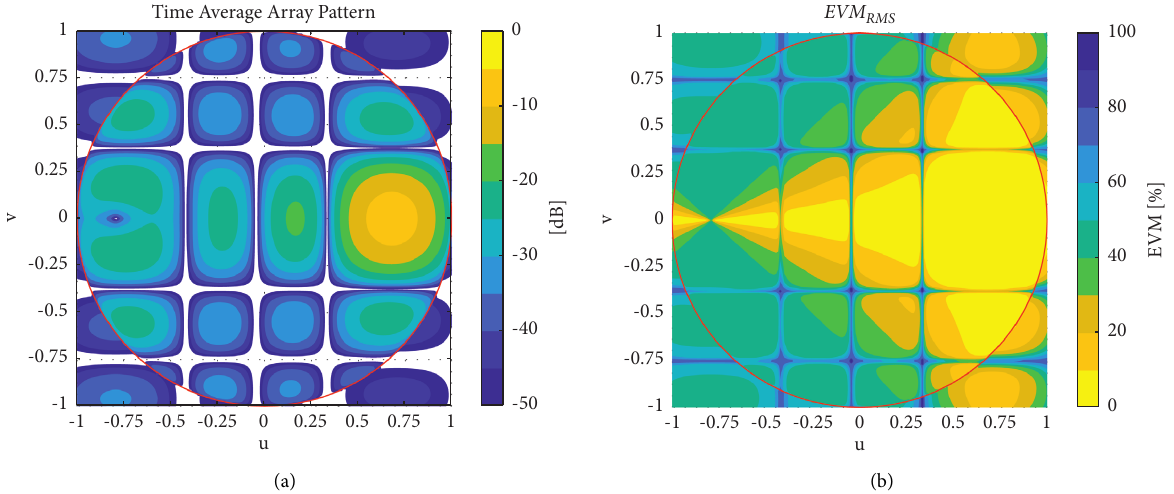
Figure 7: Scan performance of a nonsymmetric outspacing configuration with reduced element spacing with scanning to θ � 0 ° : K � L � 8, d � d �( λ ϕ /3 ) , C / N � 50 dB , the transmitted signal is QAM16, and a cos θ element power pattern is used. (a) Time x y 0 0 average array pattern. (b)